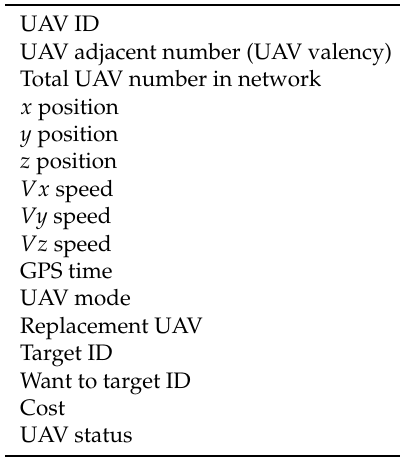
Table 2. Unmanned aerial vehicle (UAV) ( C i )